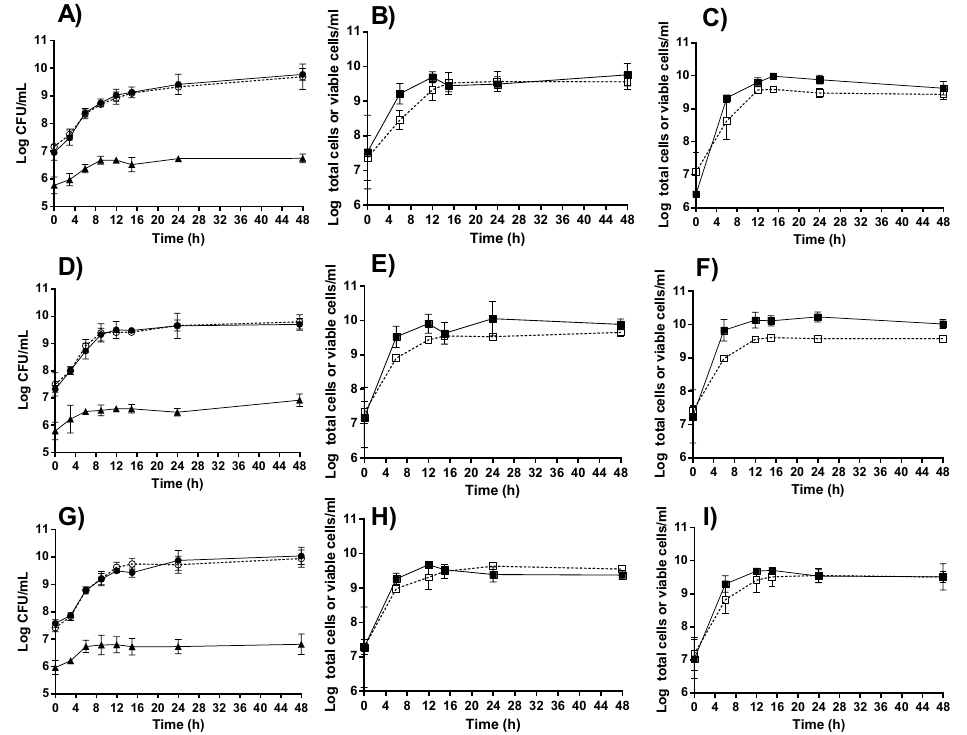
Figure 1. Growth of L. rhamnosus strains in mono (●; solid line) and co-culture (-- ○ --; dashed line) with